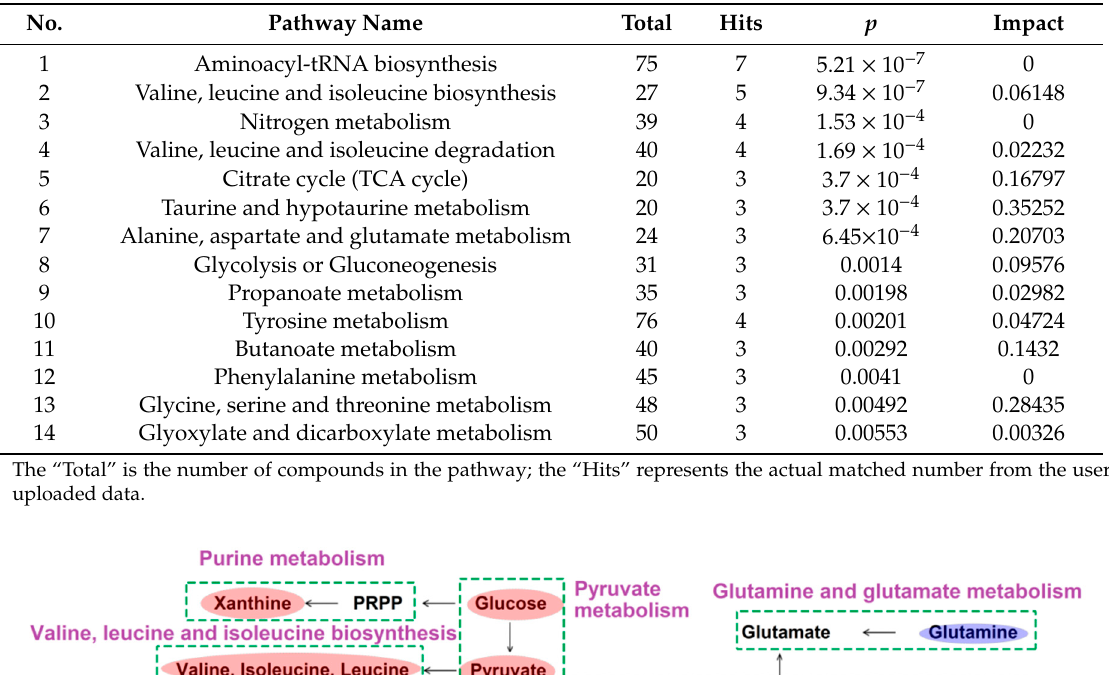
Table 2. Results of pathway analysis using MetaboAnalyst database.